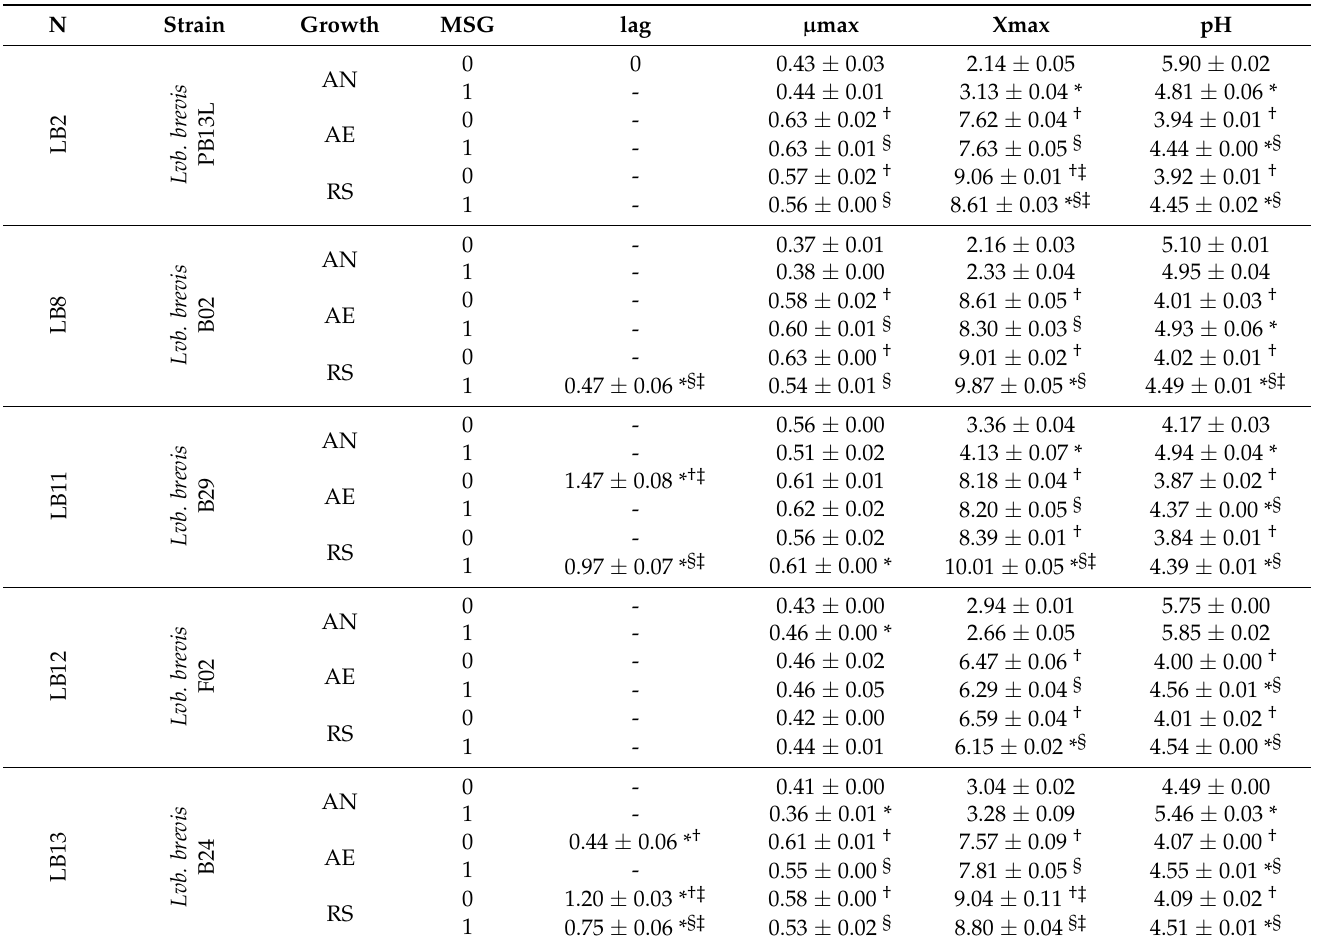
Table 1. Growth parameters of Levilactobacillus brevis strains cultivated under anaerobic, aerobic, and respiratory conditions, with or without glutamate